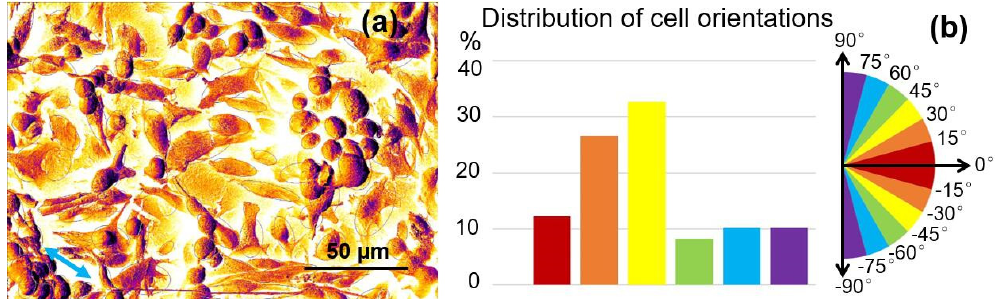
Figure 8. ( a ) The processed image of osteoblastic cells grown on the nano-ripples within the micro-hexagon, with the additional fitted ellipses by ImageJ software based on Figure 6h (the arrow indicates the orientation of the nano-ripples). ( b ) The distribution of cell orientations. The orientation angle is obtained from the angle between the direction of the nano-ripples, predefined as 0°, and the major axis of the cell measured with ImageJ software.